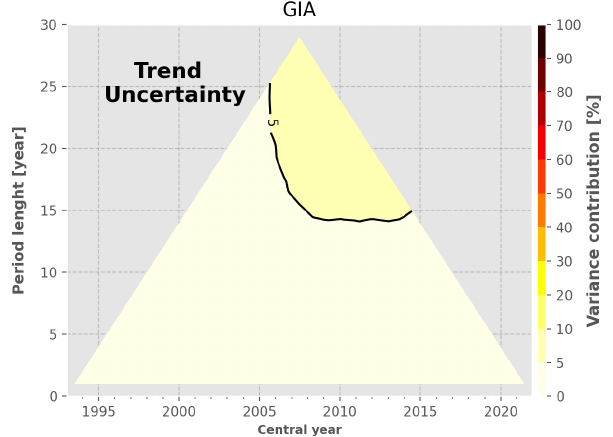
Figure A8. Variance contribution to the GMSL trend variance of the GIA drift